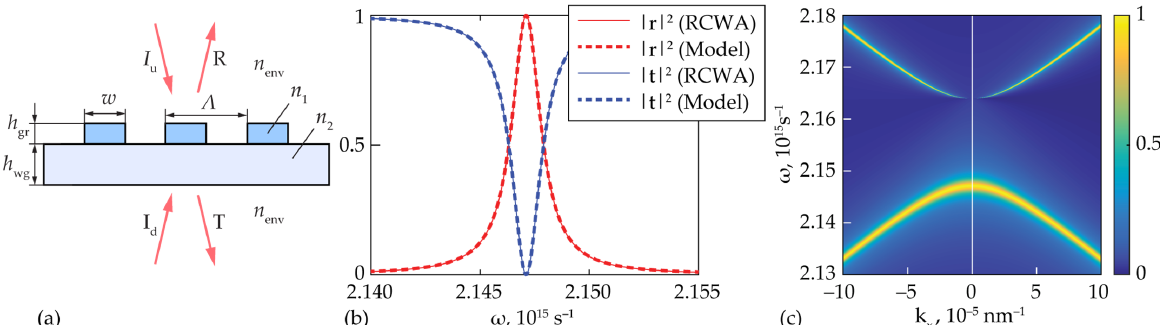
Figure 2. ( a ) Geometry of the considered guided-mode resonant grating: period Λ = 700 nm, grating height h gr = 70 nm, waveguide layer thickness h wg = 290 nm, grating ridge width w = 40 nm, refrac- tive indices n 1 = 1.99 (Si 3 N 4 ), n 2 = 1.45 (SiO 2 ), and n env = 1. ( b ) Reflectance | r ( ω ) | 2 = (cid:12) r u,d ( ω ) (cid:12) and transmittance | t ( ω ) | 2 of the grating for the case of a TE-polarized normally incident wave. Dashed lines show the approximations calculated using Equation (8); solid lines show the rigorously calculated spectra. ( c ) Reflection coefficient | r ( k x , ω ) | of the grating calculated using RCWA (left half, k x < 0) and using the resonant approximation (8) (right half, k x > 0). Approximation parameters: ω p1 = ( 2147.11 − 0.80i ) · 10 12 s − 1 , ω p2 = 2.1640 · 10 15 s − 1 , v g = 0.695c, ϕ = − 2.72, ξ = −